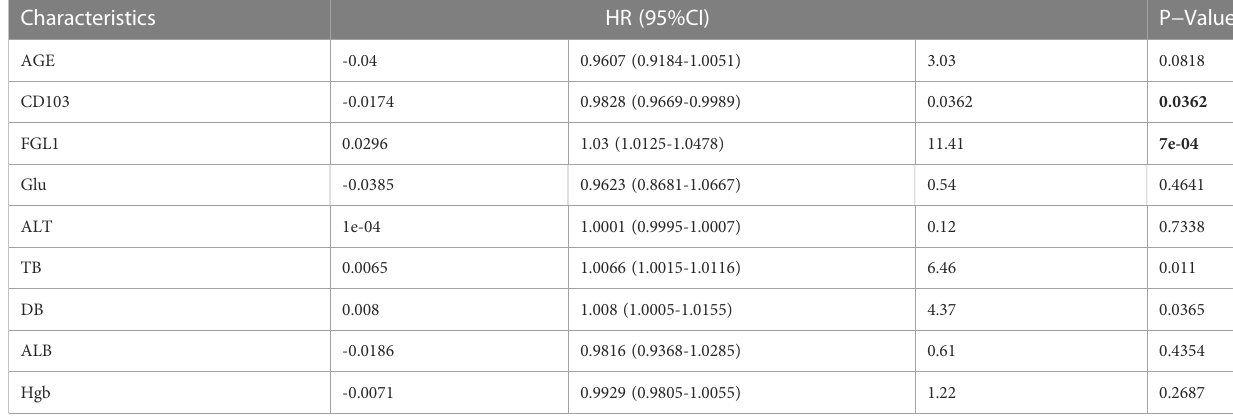
TABLE 1 Univariate Cox regression analysis of potential prognostic factors in HCC.